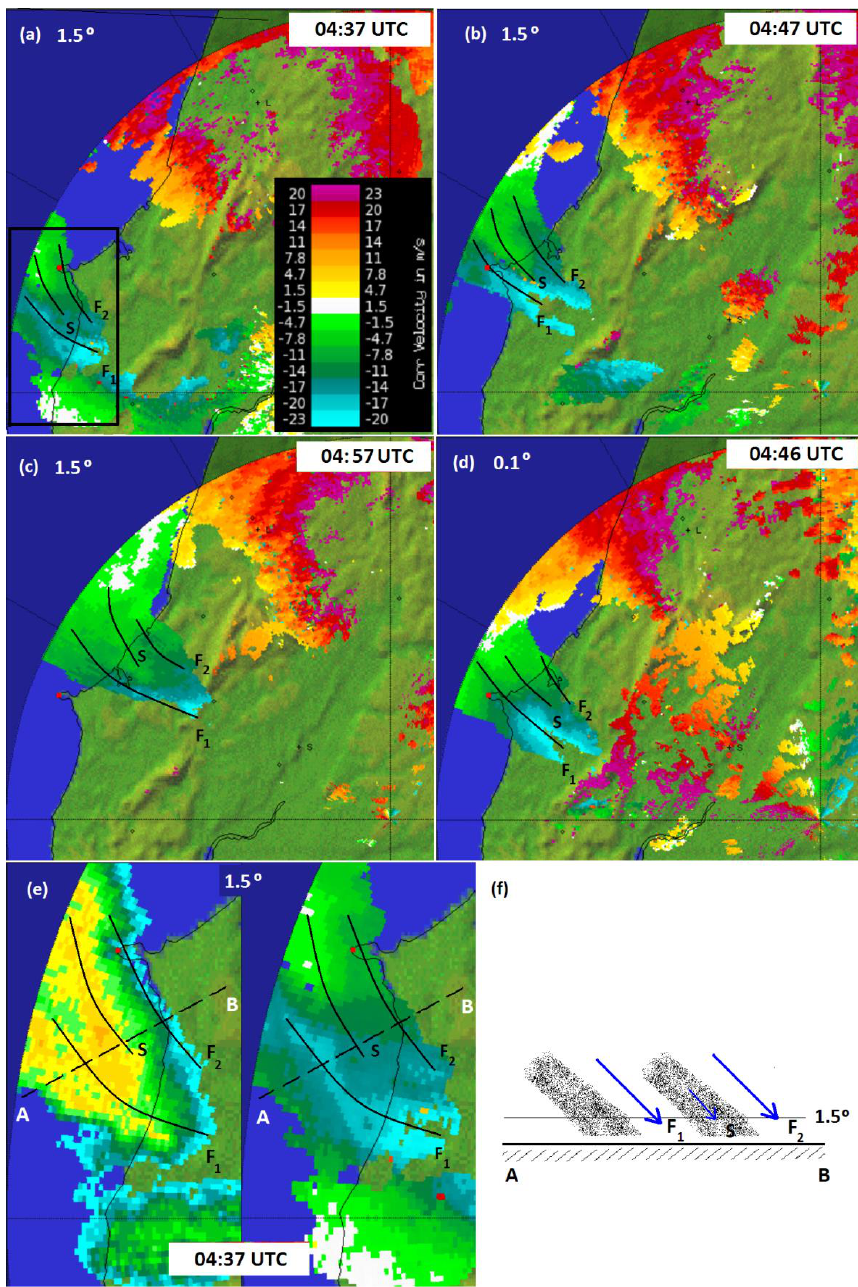
Figure 12. PPI of SRV (m s −1 ) from CL radar, 1.5° tilt at ( a ) 04:37 UTC, ( b ) 04:47 UTC and ( c ) 04:57 UTC, and 0.1° tilt at ( d ) 04:46 UTC, on 23 December 2009. ( e ) Zoom-in area [marked in ( a )] of the PPI of reflectivity (left) and SRV (right), from 1.5° tilt, at 04:37 UTC. The SRV scale was tailored, excluding magnitudes > 23 m s −1 . “F1” and “F2” denote faster descending airflows and “S” denotes slower descending airflow. Black lines represent the axis of these flows. The reflectivity scale is the same as in Figure 7. The line AB in ( e ) represents the transect AB shown in ( f ). ( f ) Diagram showing the interpretation of ( e ), where the dark shades represent cloud material and adjacent white areas represent drier areas; the arrows represent faster and slower descending flows according to their length, and the horizontal line above ground denotes the 1.5° tilt intersection with the cloud head tip. Cabo Carvoeiro station is represented by a red square, for reference.